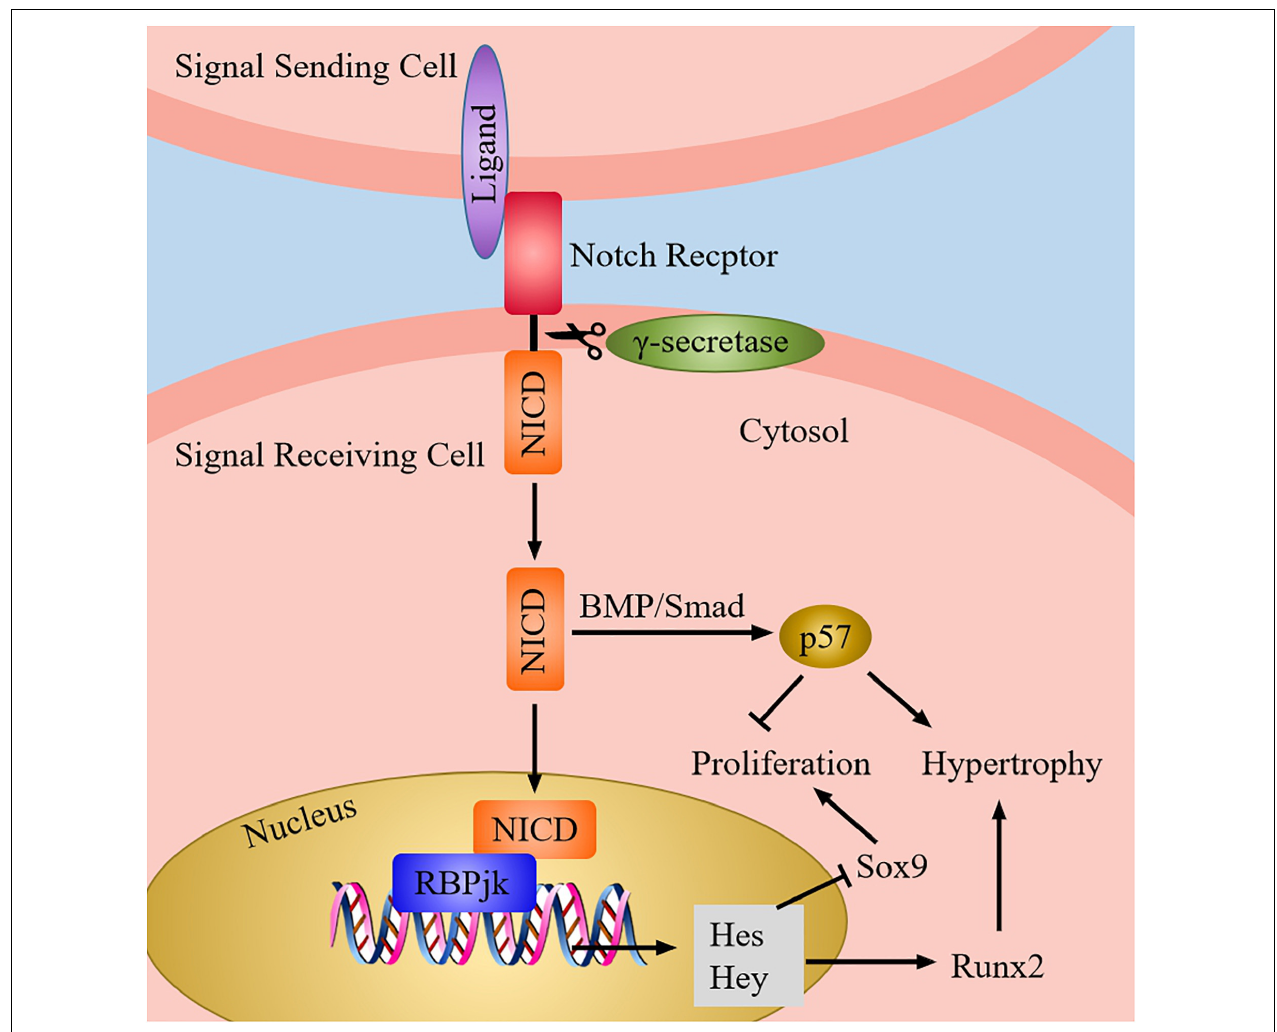
FIGURE 7 | The Notch signaling pathway in chondrocytes. When Notch signaling is produced, Notch ligand of adjacent cells bind to Notch receptor, then the receptor is cleaved by γ -secretase to release the NICD. Next, NICD enters the nucleus and interact with RBPjk to induce the target genes expression (Hes and Hey). Afterward, the expression of Sox9 is inhibited, whereas the expression of Runx2 is increased. Besides, Notch also can induce the expression of p57 via BMP/Smad signaling to promote chondrocyte hypertrophy and suppress chondrocyte